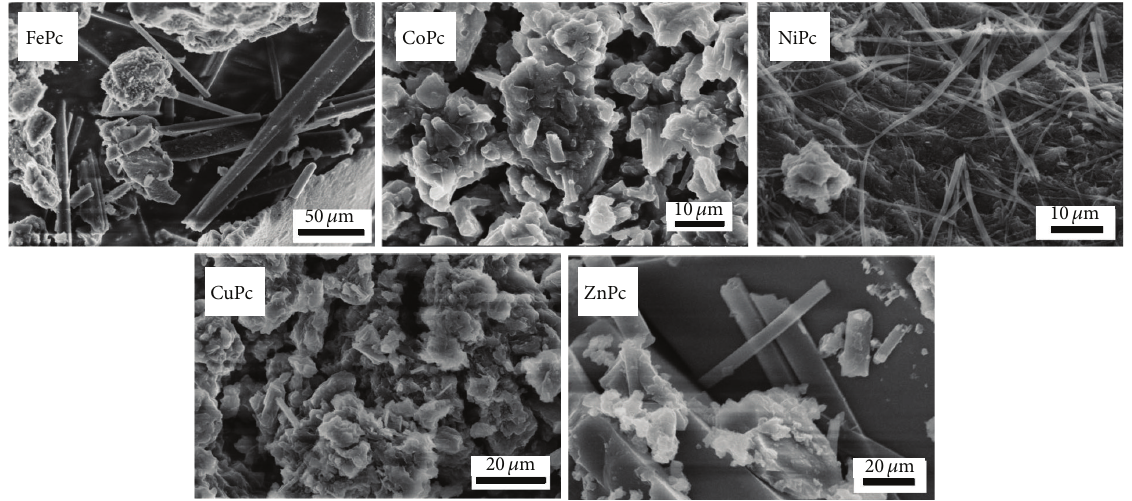
Figure 3: The electron micrographs of